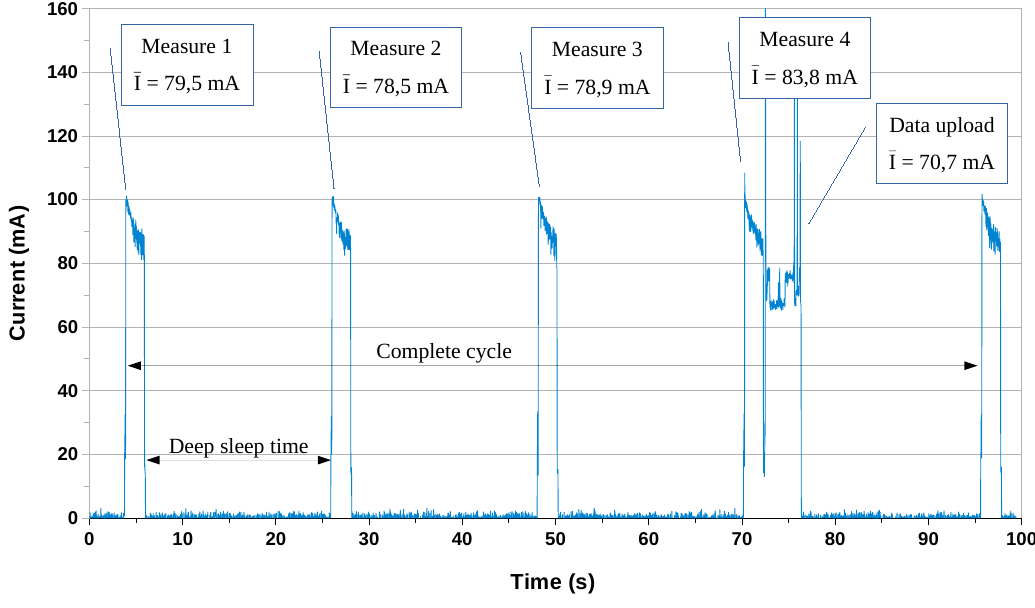
Figure 12. Typical evolution of the power consumption, considering a batch of 4 measurements and a rest period of 20